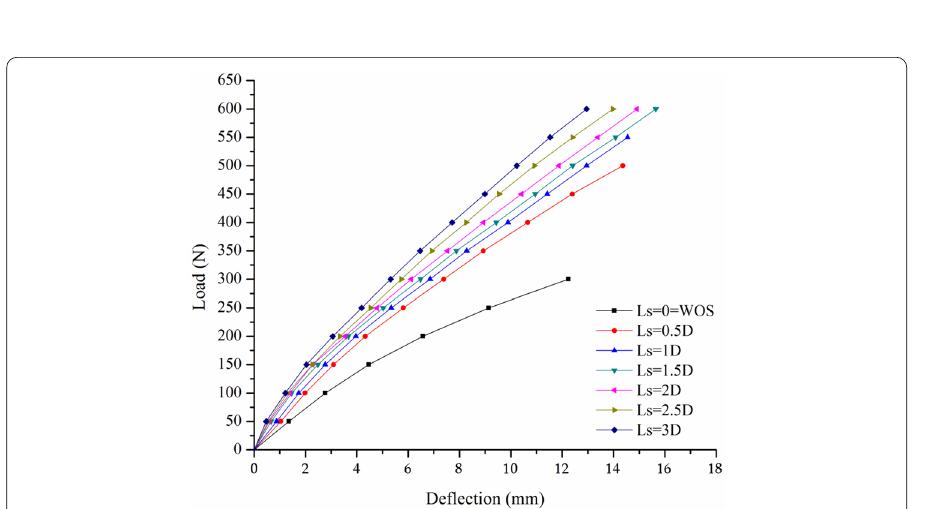
Fig. 5 Lateral load defection behavoiur of 50.8 mm diameter pile with embedded depth of 800 mm